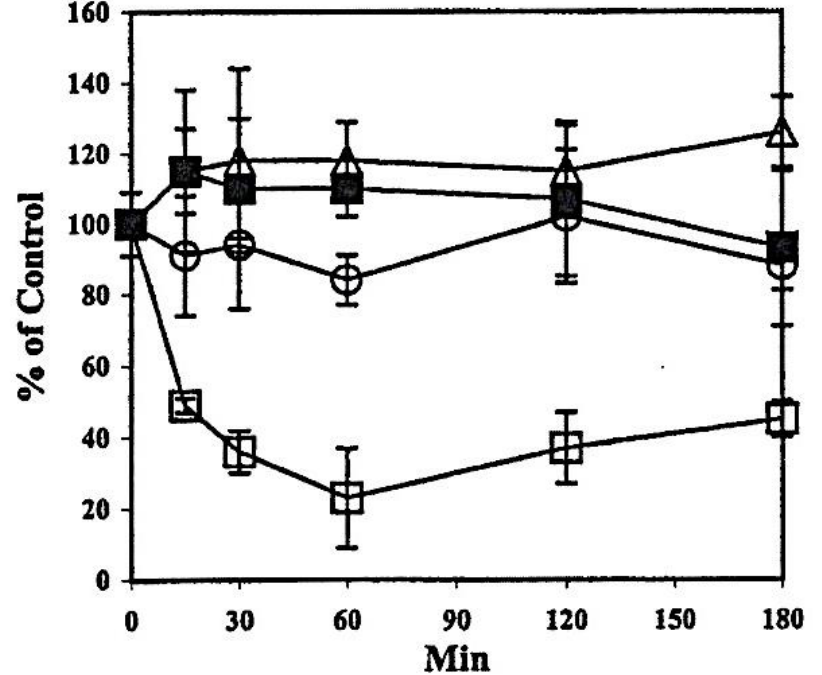
Figure 6. Effect of a bolus of H 2 O 2 on the activities of oxidation defense enzymes in HLE B3 cells. The activity is expressed as % of control untreated cells in three separate experiments (mean ± S.D.). The basal enzyme activity (untreated cells) was 7.8 ± 1.3 mU/mg protein for TTase; 142.4 ± 8.0 mU/mg protein for GST; 12.8 ± 1.4 mU/mg protein for GR and 18.7 ± 4.7 mU/mg protein for GPx. - ∆ - GR, ⟥ GPx, - - GST, - ◼ - TTase. Reprinted with permission from Xing and Lou, EER (2002); Copyright Elsevier 2002 [55].